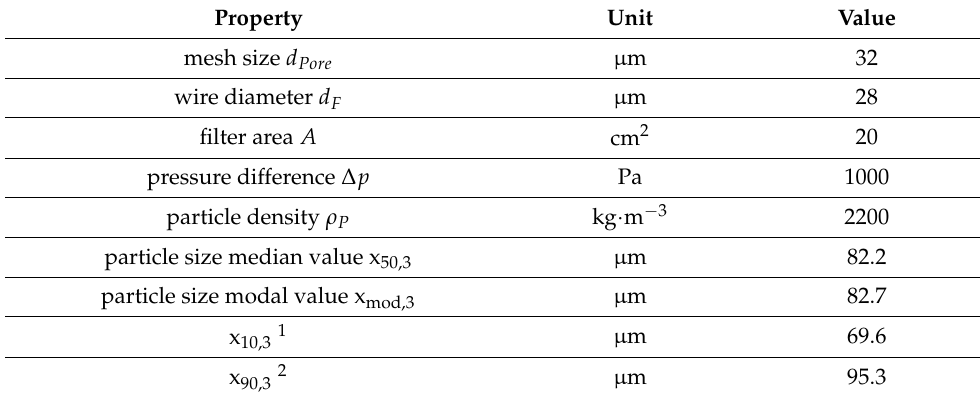
Table 1. Parameters of the